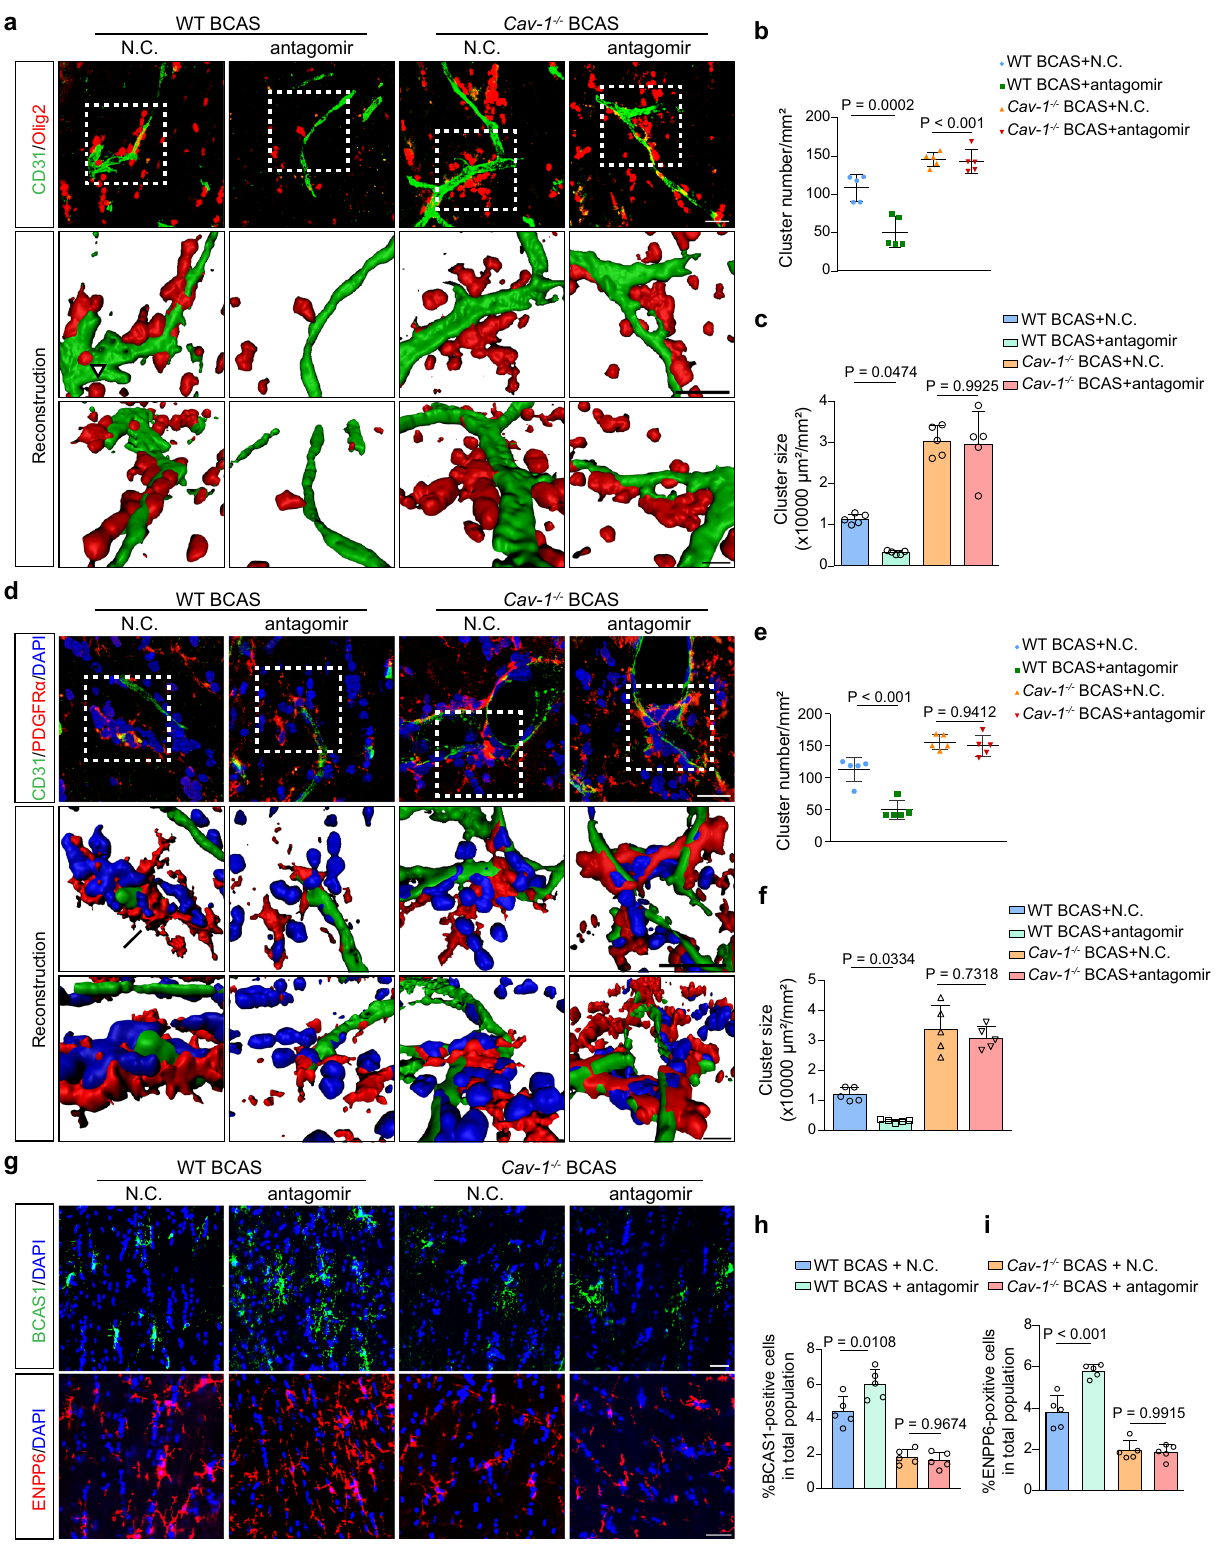
Fig. 10 | PEI-antagomir ameliorates OPC perivascular clustering and promotes remyelination via Cav-1. a Representative immuno fl uorescent images and reconstruction showing the attenuation in perivascular Olig2 + cell clusters in wild typeand Cav-1 − / − micetreatedwithantagomir(n=5mice/group).Scalebar,20 μ m. b , c Quantitative analyses of cluster number and size around CD31 + vessels ( n =5 mice/group). d Perivascular clustering of PDGFR α + OPCs in mice of 2 genotypes